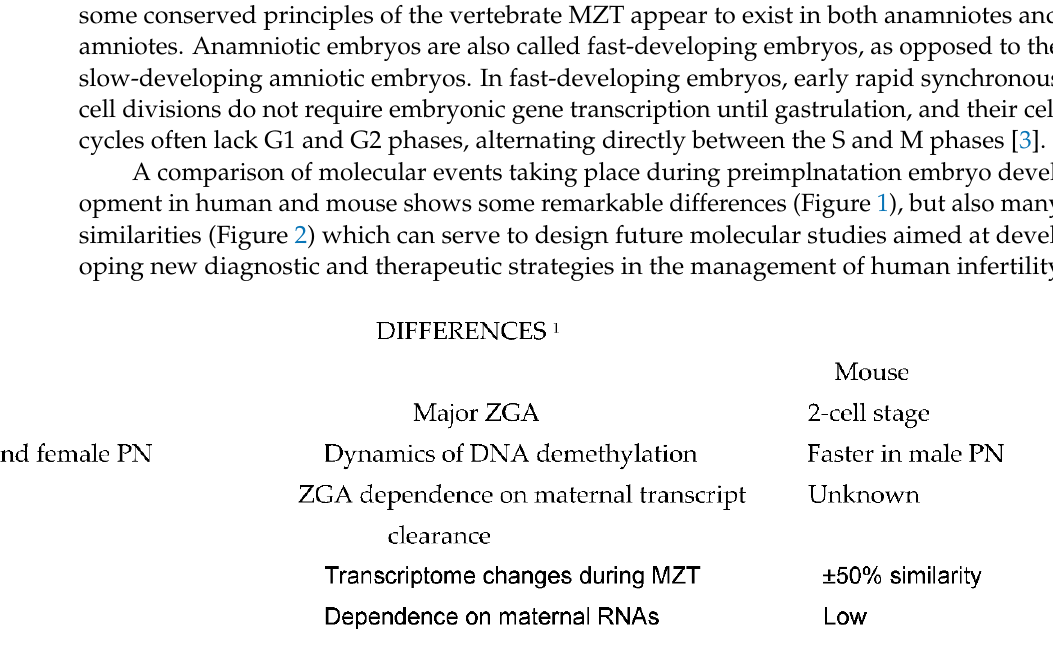
Figure 1. Differences between the basic molecular events taking place in human and mouse embryos. Explanations: 1 Comparisons are to be made taking into account the differences in ZGA timing. Abbreviations: ZGA: zygote gene activation; PN, pronuclei; MZT: maternal-to-zygotic transition of embryo developmental control.